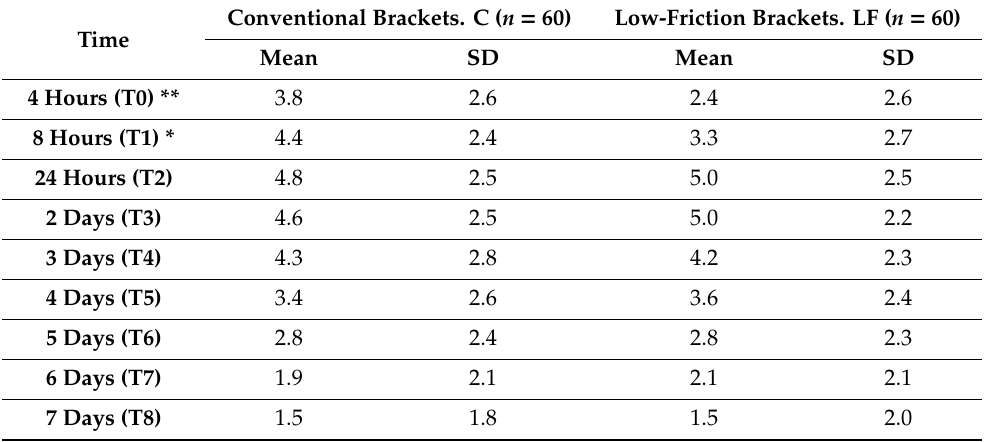
Table 4. Pain on the VAS between groups at the di ff erent evaluation times ( n =